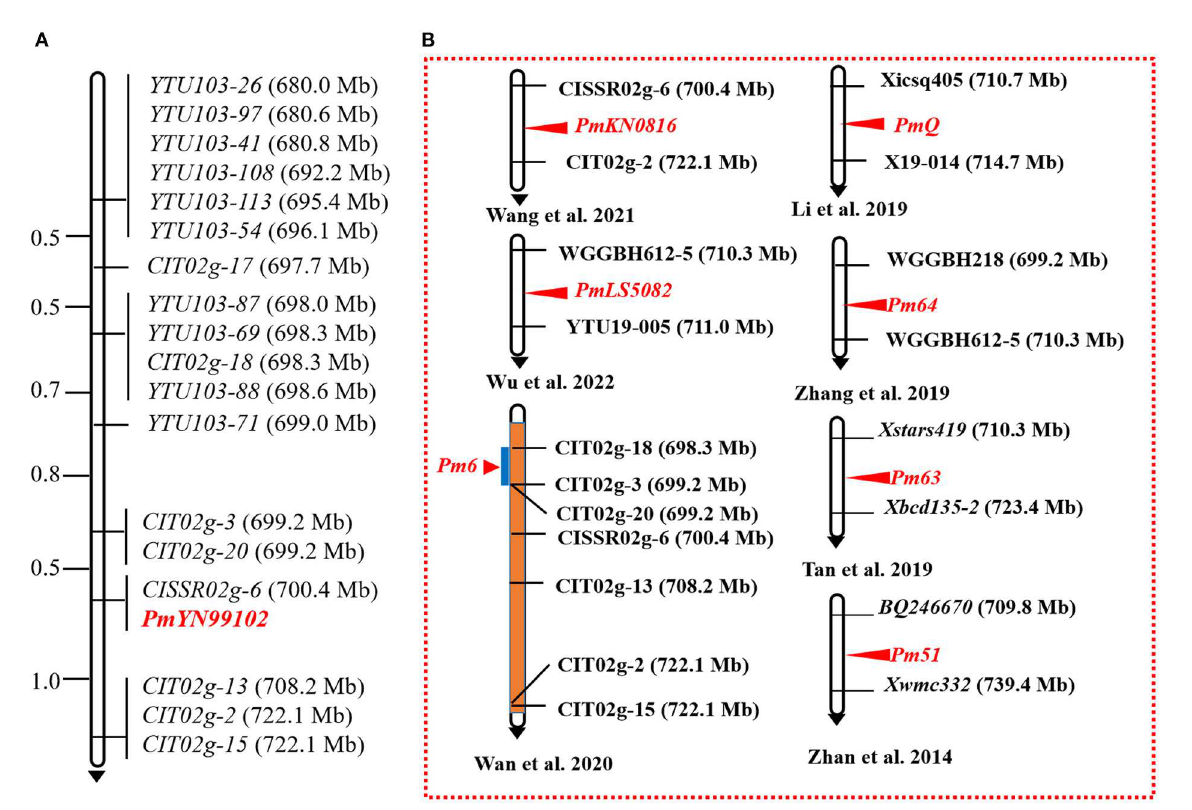
FIGURE4 Linkage map of pmYN99102 using the F 2 : 3 families of Yannong 99102-06188 × Jinhe13–205 (A) and the physical locations of cataloged Pm genes on chromosome arm 2BL (B). Genetic distances in cM are showed to the left. The black arrows point to the